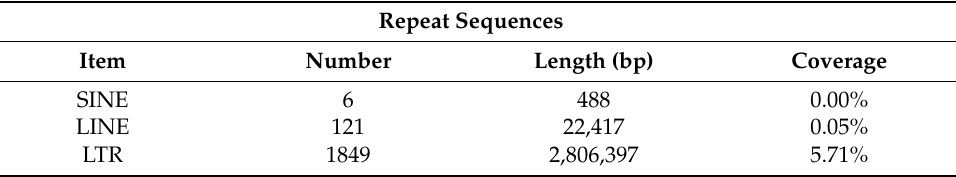
Table 1. Characteristics of the repeat sequences and non-coding RNA of G. lingzhi